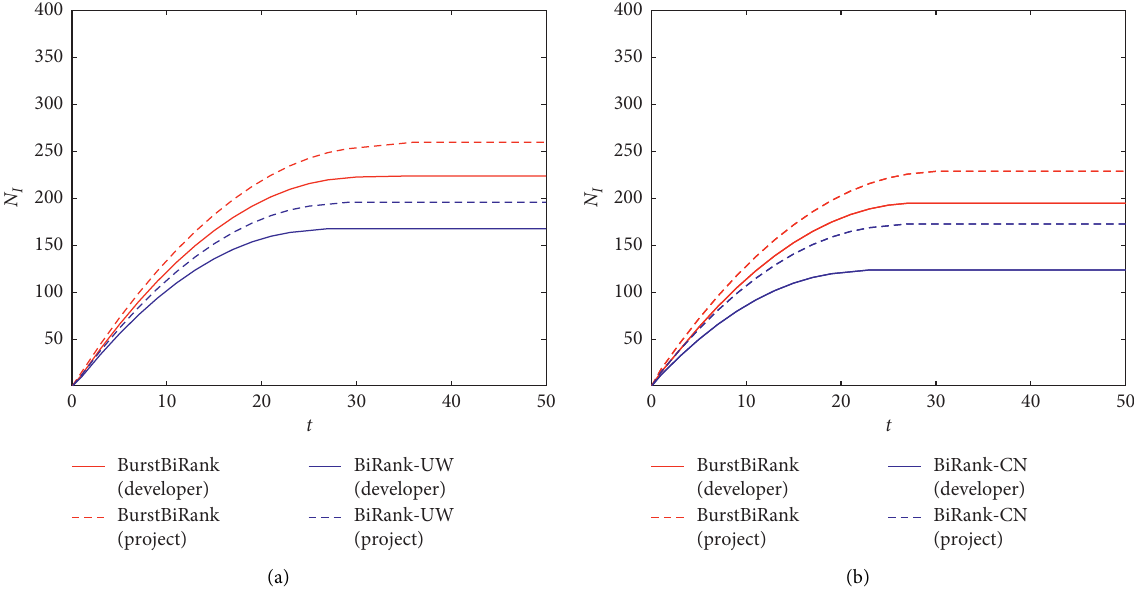
Figure 5: Performance comparison between BurstBiRank and BiRank. (a) BurstBiRank vs. BiRank-UW. (b) BurstBiRank vs. BiRank-CN.